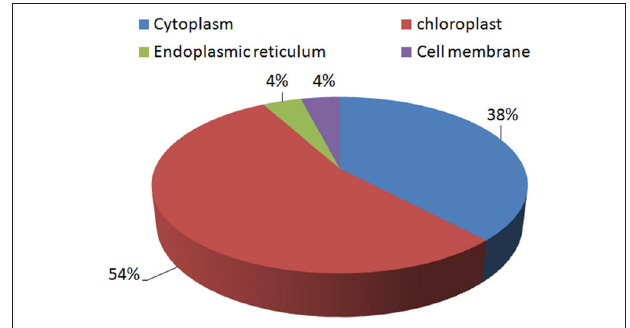
FIGURE 6 | Distribution of the identified proteins according to their sub-cellular